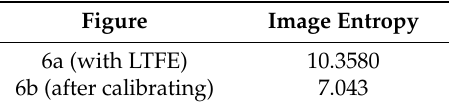
Table 4. Image entropy of Figure 6. Figure